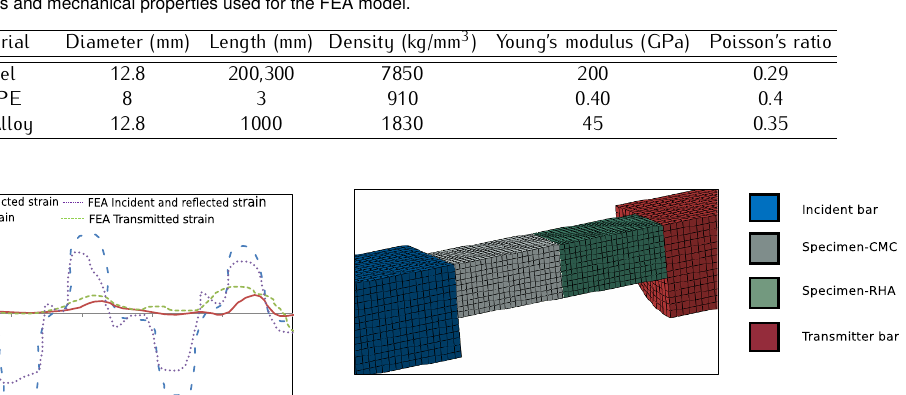
Figure 8. CMCandRHAtestspecimeninSHPBfiniteelementmodel.